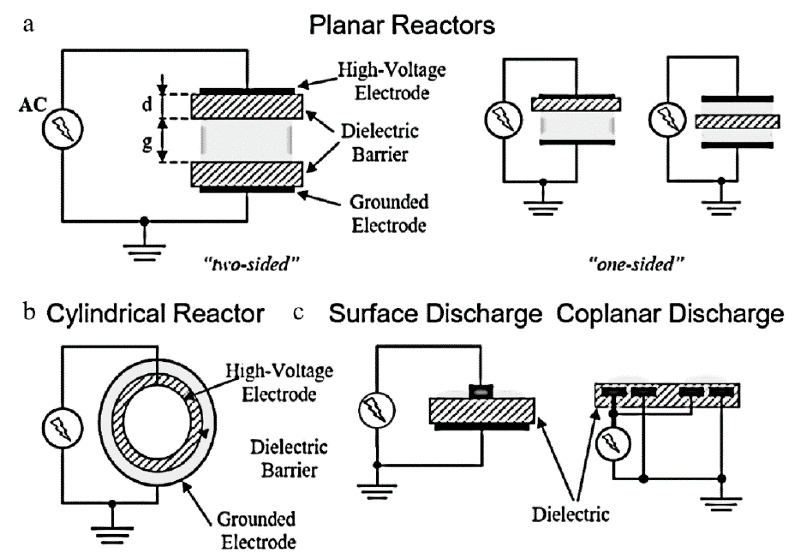
Figure 1. Two typical DBD electrode devices: ( a ) planar reactor; ( b ) cylindrical reactor; ( c ) two discharge types of surface discharge and coplanar discharge. Reproduced with permission from [8]; Copyright Elsevier, 2003.